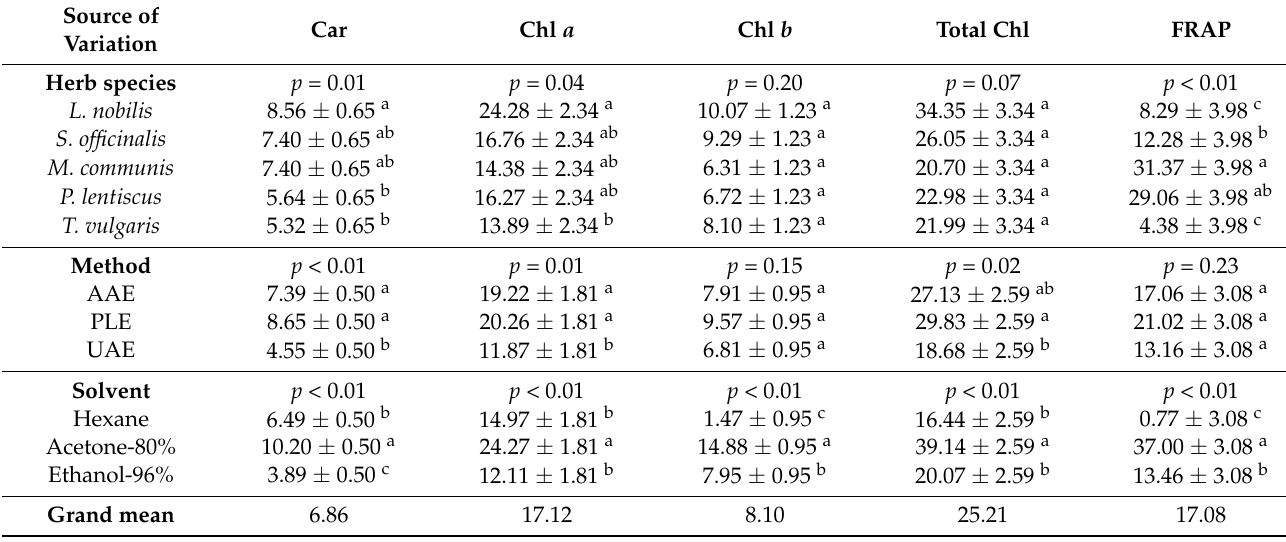
AAE = agitation-assisted extraction, PLE = pressurized liquid extraction, UAE = ultrasound-assisted extraction, Car = carotenoid, Chl = chlorophyll. Results are expressed as mean ± SE. Total chlorophyll content refers to the sum of Chl a and Chl b . Different letters within columns indicate significant differences according to Tukey’s test at p ≤